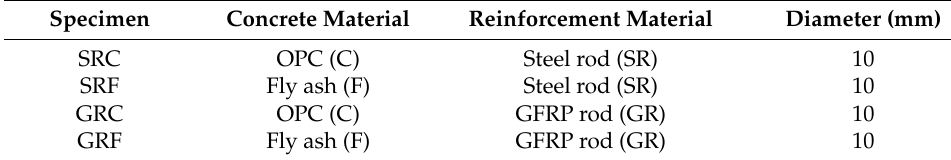
Figure 1. Photograph of GFRP rods. Table 4. Details of Test